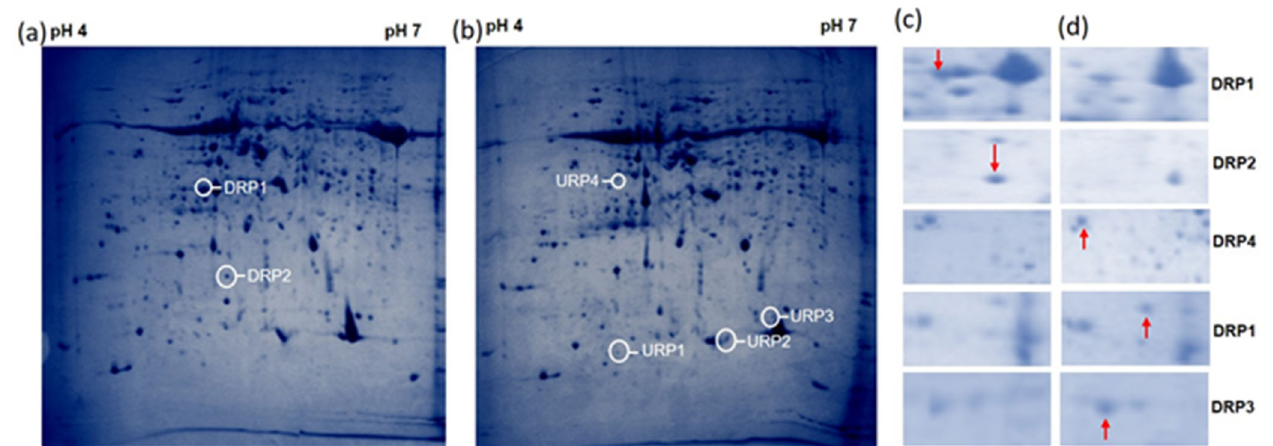
Figure 5. R. solani ‐ induced proteome shift in barley cv. NDB ‐ 1445: total proteins were extracted from barley cv. NDB1445 and analyzed by 2 ‐ DE protein electrophoresis. In panel ( a ): complete 2D protein profile of barley var. NDB ‐ 1445 without R. solani infection. In panel ( b ): complete 2D protein profile of barley cv. NDB ‐ 1445 48 h post ‐ inoculation of R. solani . The spots which were more intense in the control are shown with a downward arrow ( ↓ ), and the spots which were more intense in the R. solani cells are shown with an upward arrow ( ↑ ). After image analysis, 39 protein spots were found to be differentially expressed quantitatively between the two situations. In panels ( c , d ): some of the representative differentially expressed enlarged regions of the protein profile from panels ( a , b ). Here, URP and DRP represent the up ‐ regulated and down ‐ regulated protein spots, respectively.